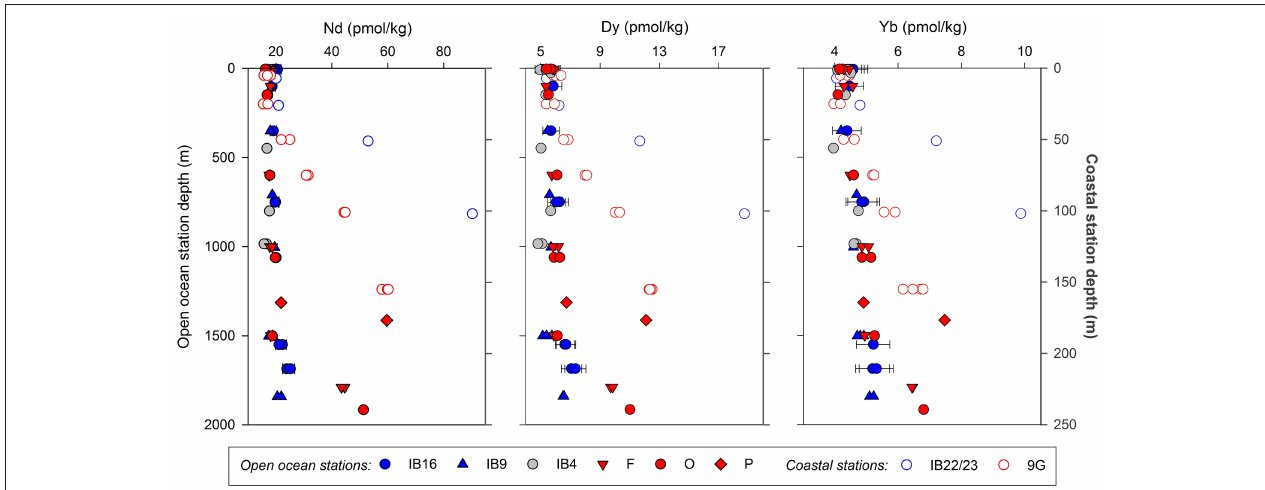
FIGURE 4 | Concentration-depth profiles of selected REE to span the light (Nd), middle (Dy) and heavy (Yb) range. All concentrations are in pmol/kg. Error bars represent 2 σ uncertainty from repeat measurement of the BATS 2000m reference seawater during the study (Table 2) . To note, surface waters from O and all 9G samples were not